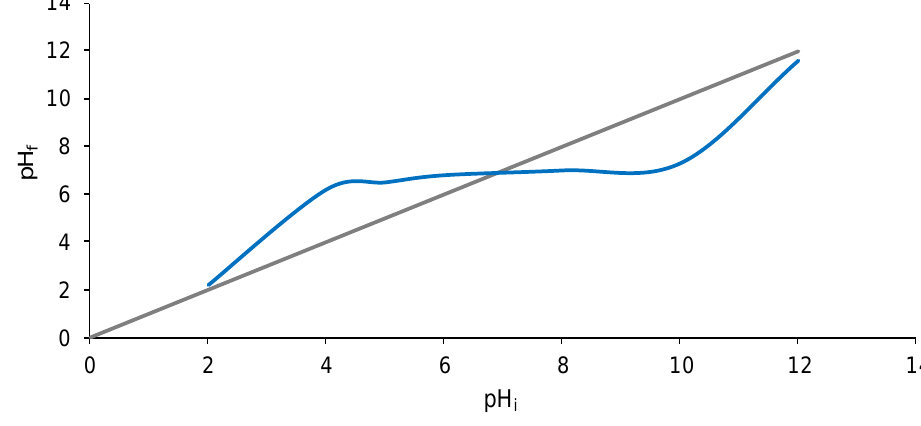
Figure 3. pH PZC of SPRBA 5% biosorbent.